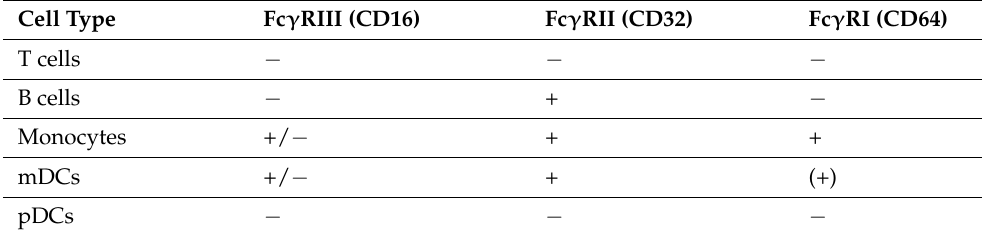
Table 2. Direct binding of bIgG and bIgG-immune complexes to monocytes.